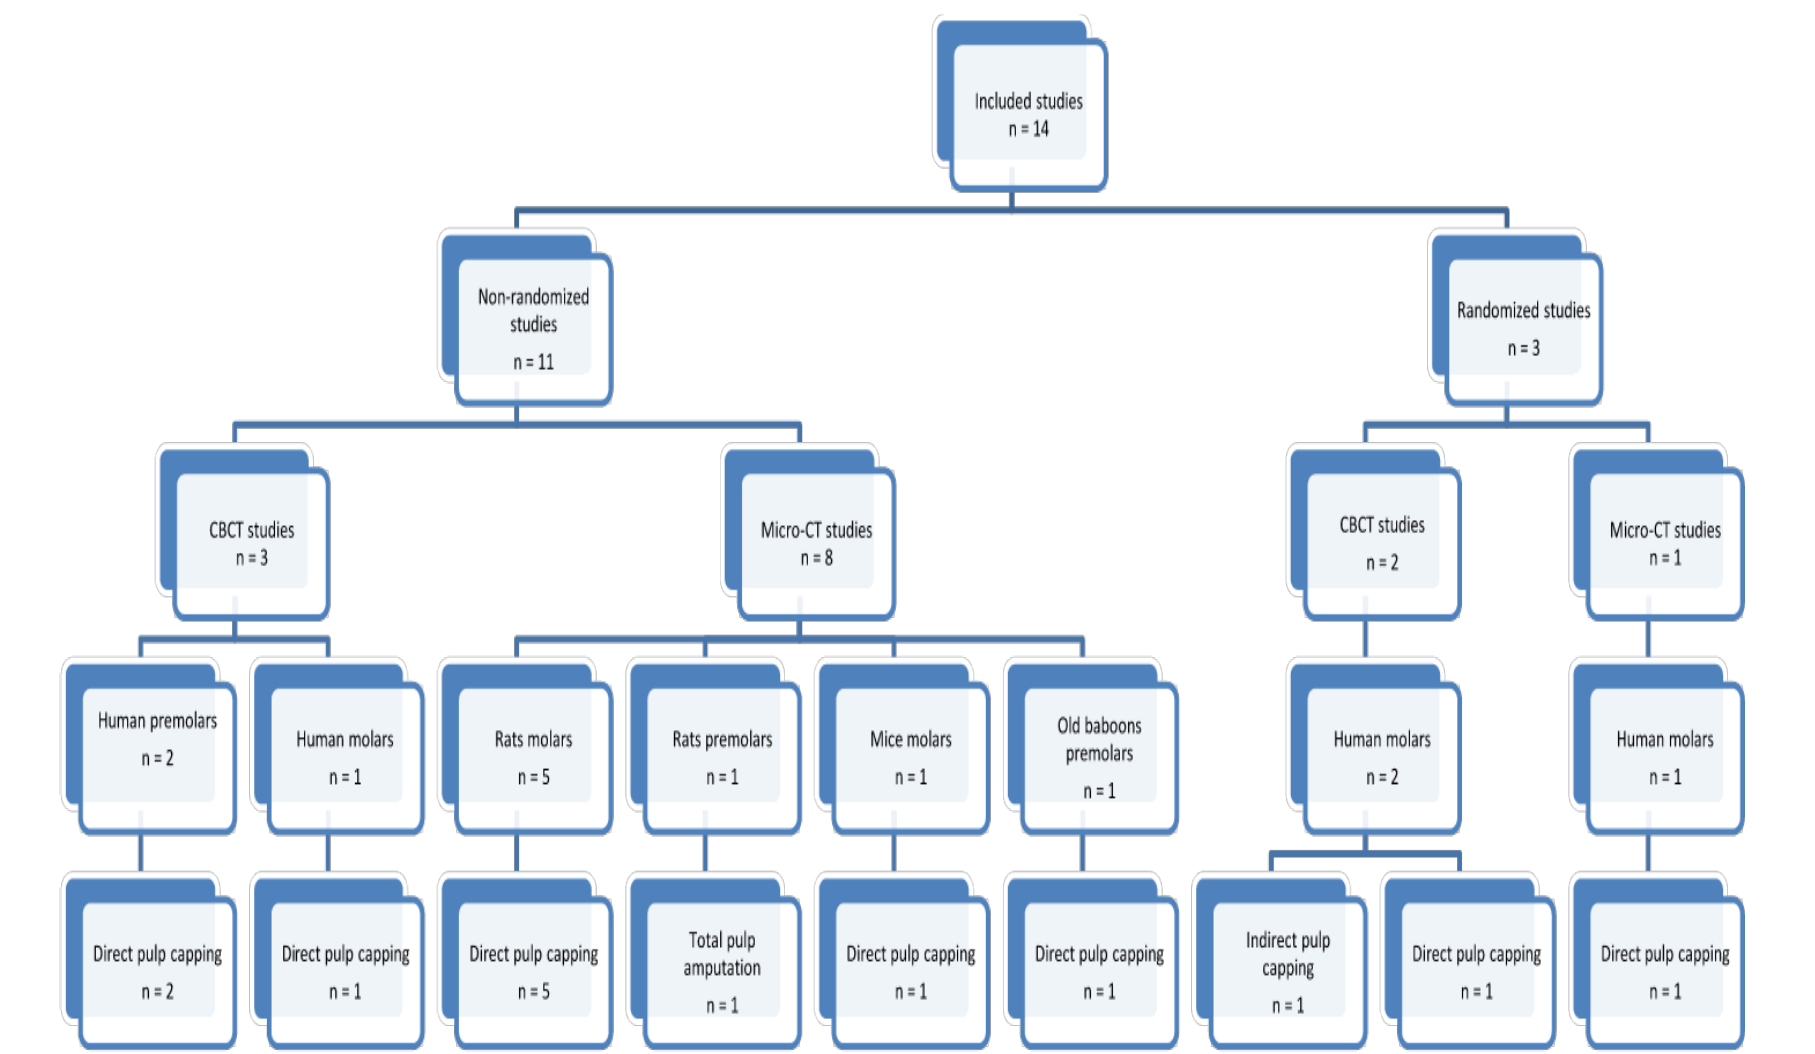
Figure 3. Diagram of the included studies in the analysis.